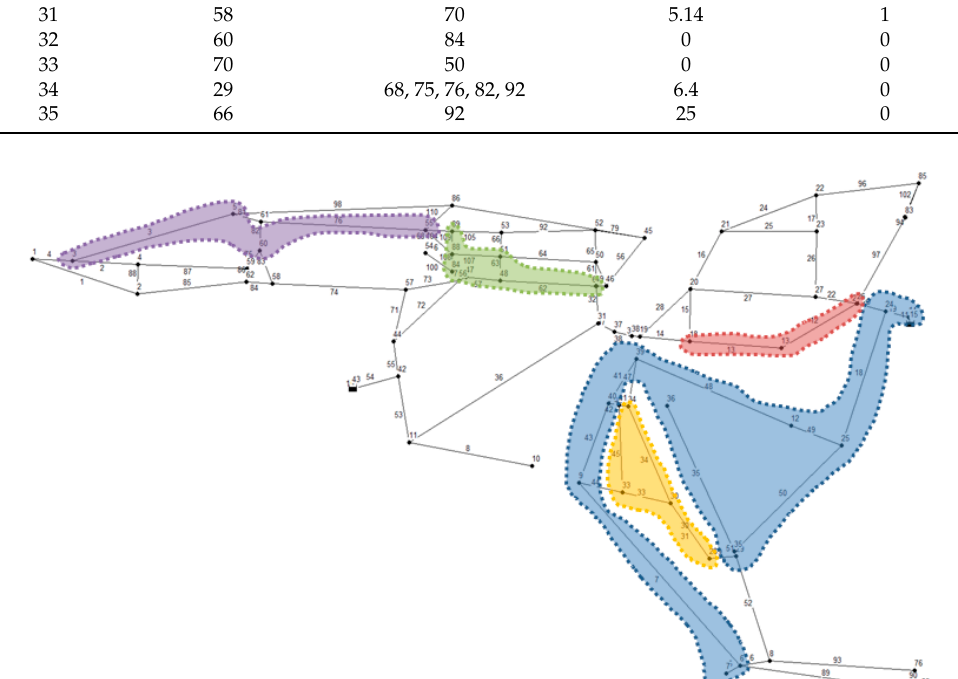
Figure 8. Five segments above the dividing priority.